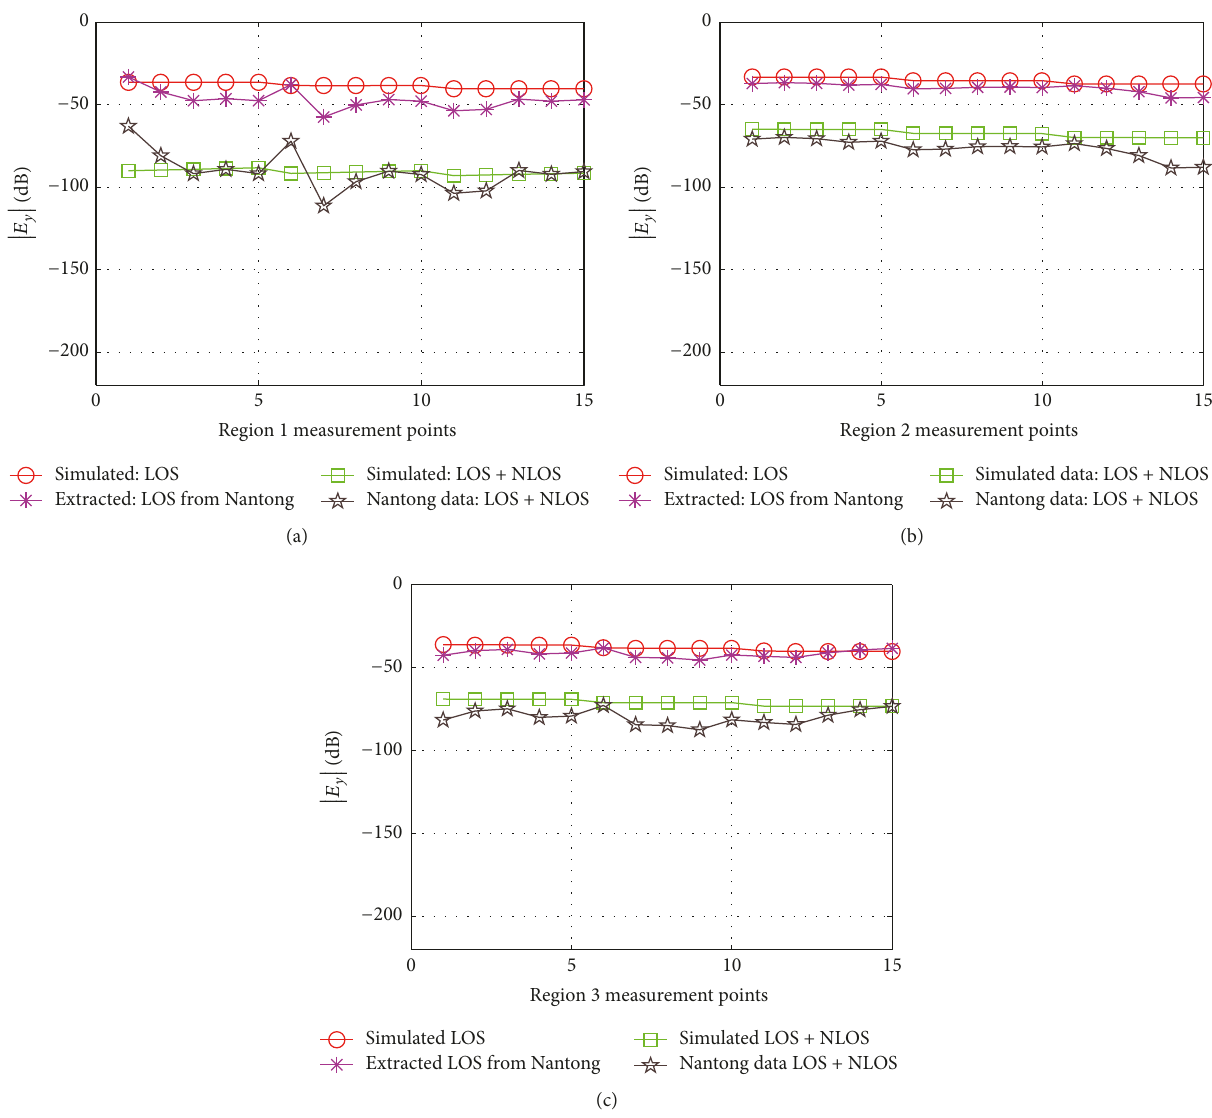
radiated field. The measured results also show that